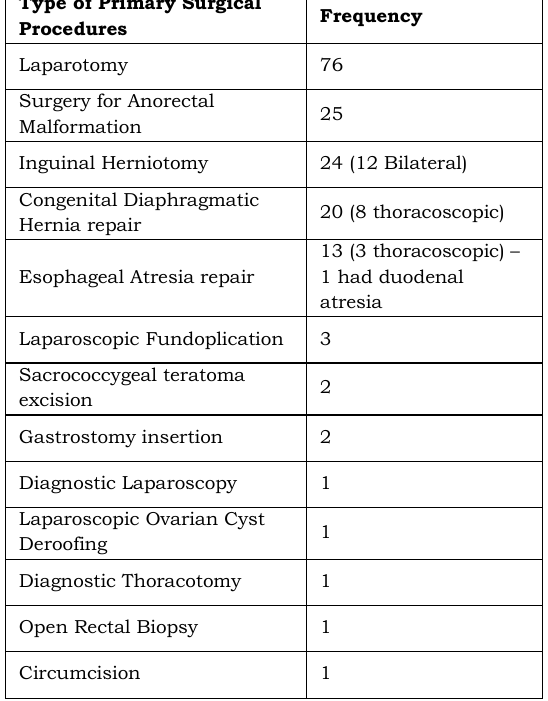
Table 1: Types of primary procedures performed and frequency. Type of Primary